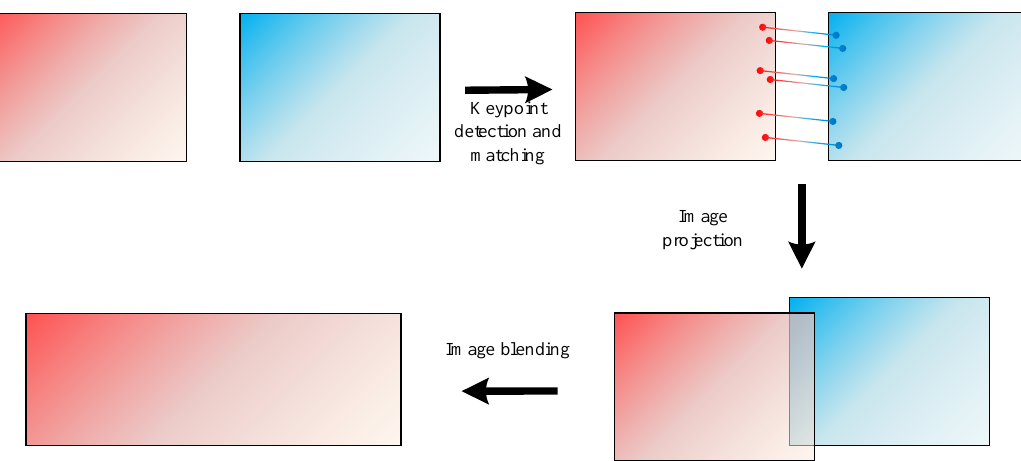
Figure 2. The traditional feature-based image mosaic process.